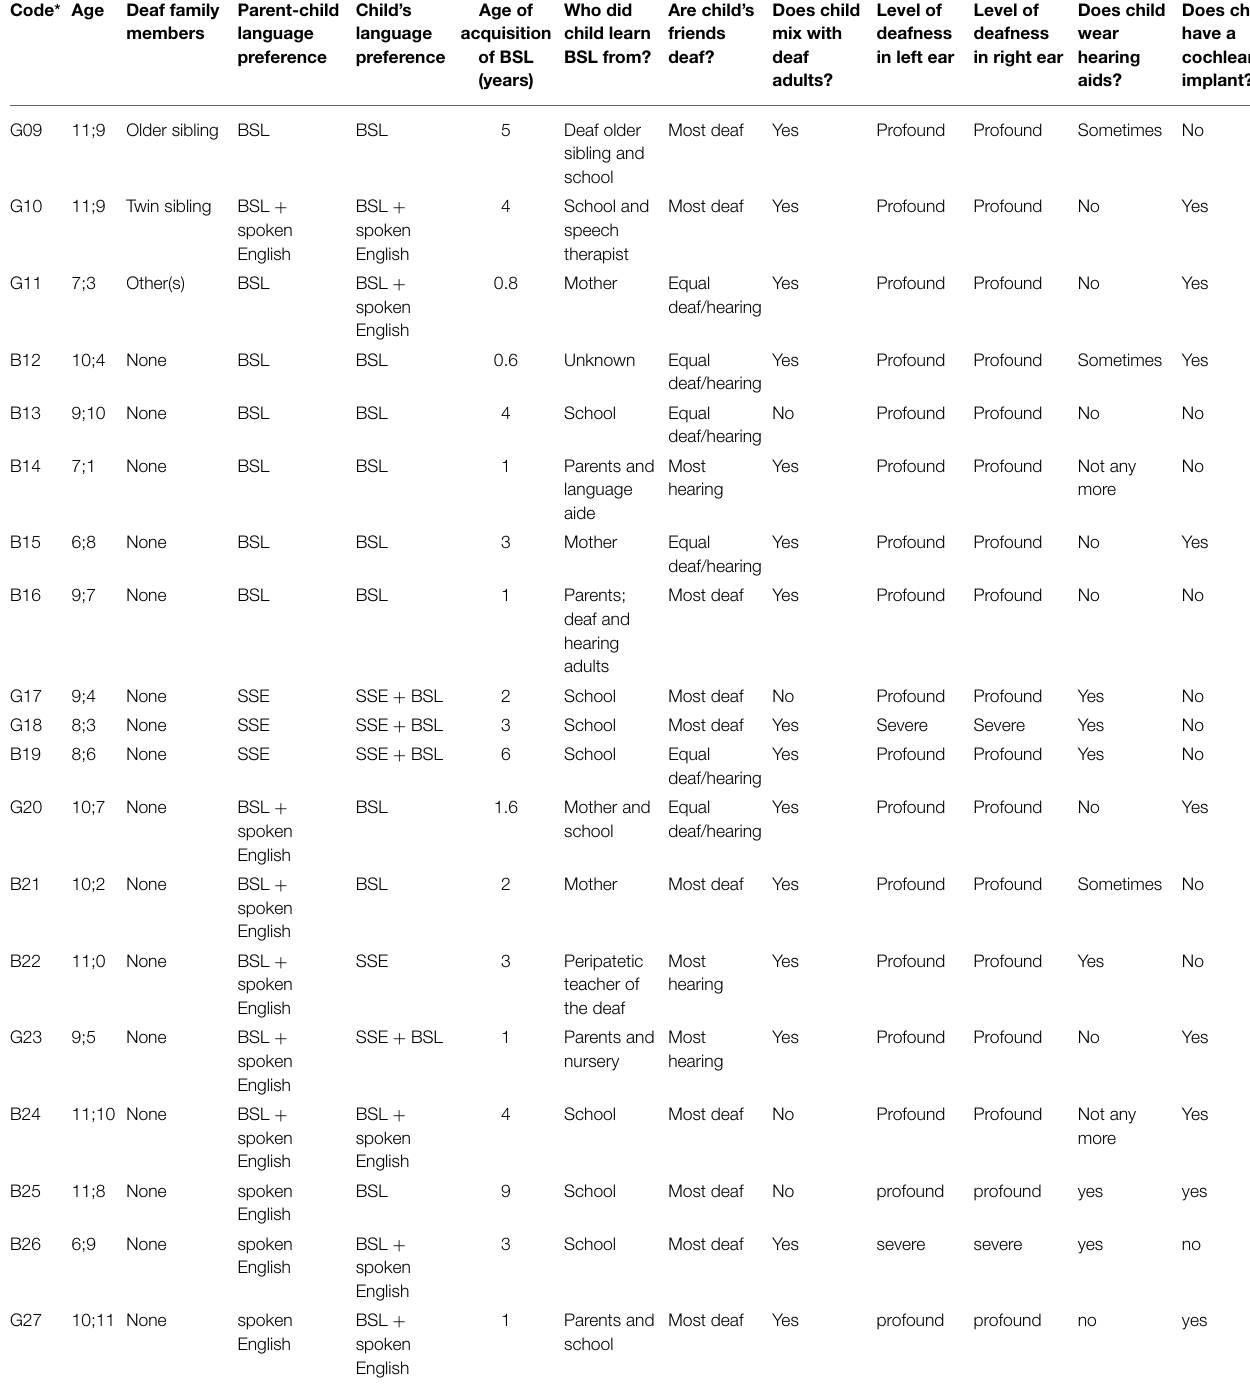
TABLE 2 | Language background of deaf non-native signers. Code * Age Deaf family